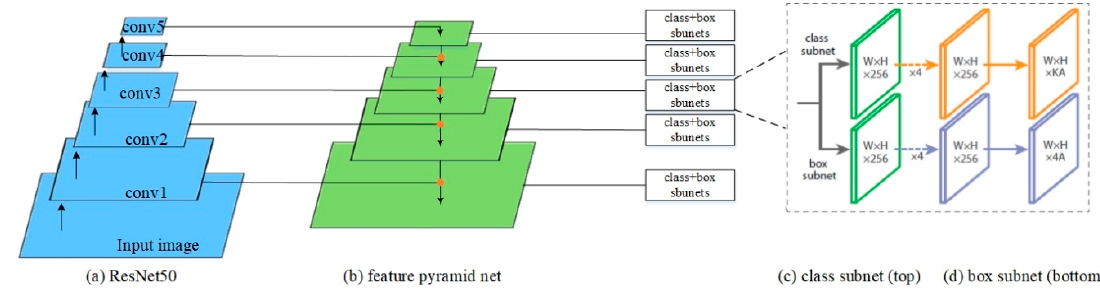
Figure 4. The network structure.